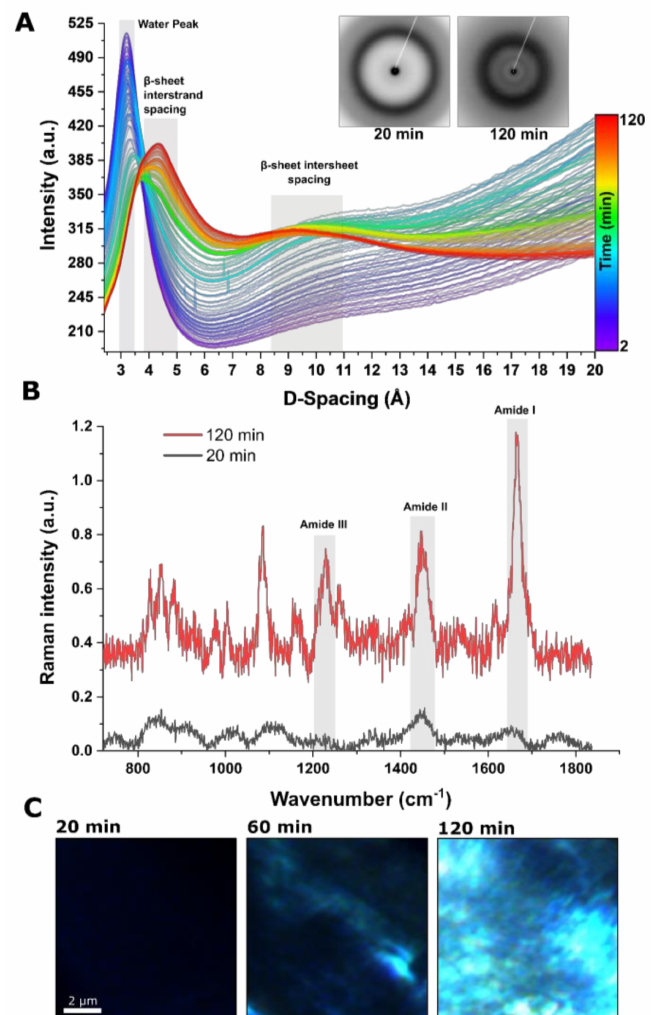
Figure 3. Probing structural evolution of skin at the water–air interface using time-resolved in situ synchrotron WAXS measurements corresponding to Figure 2. ( A ) Extracted one-dimensional diffractogram for the period of 120 min. ( B ) RAMAN spectrum for the first and last time points as in ( A ). ( C ) Polarized microscopy images of skins at various time points placed between two crossed polarizers at 45 ◦ with respect to their axis, illustrating the increase in the birefringence of the specimens over